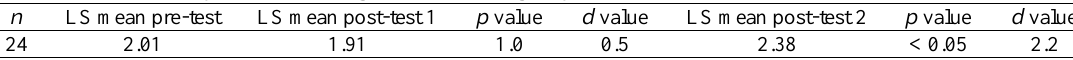
Table 6 ANOVA for problem-solving of the control group n LS mean